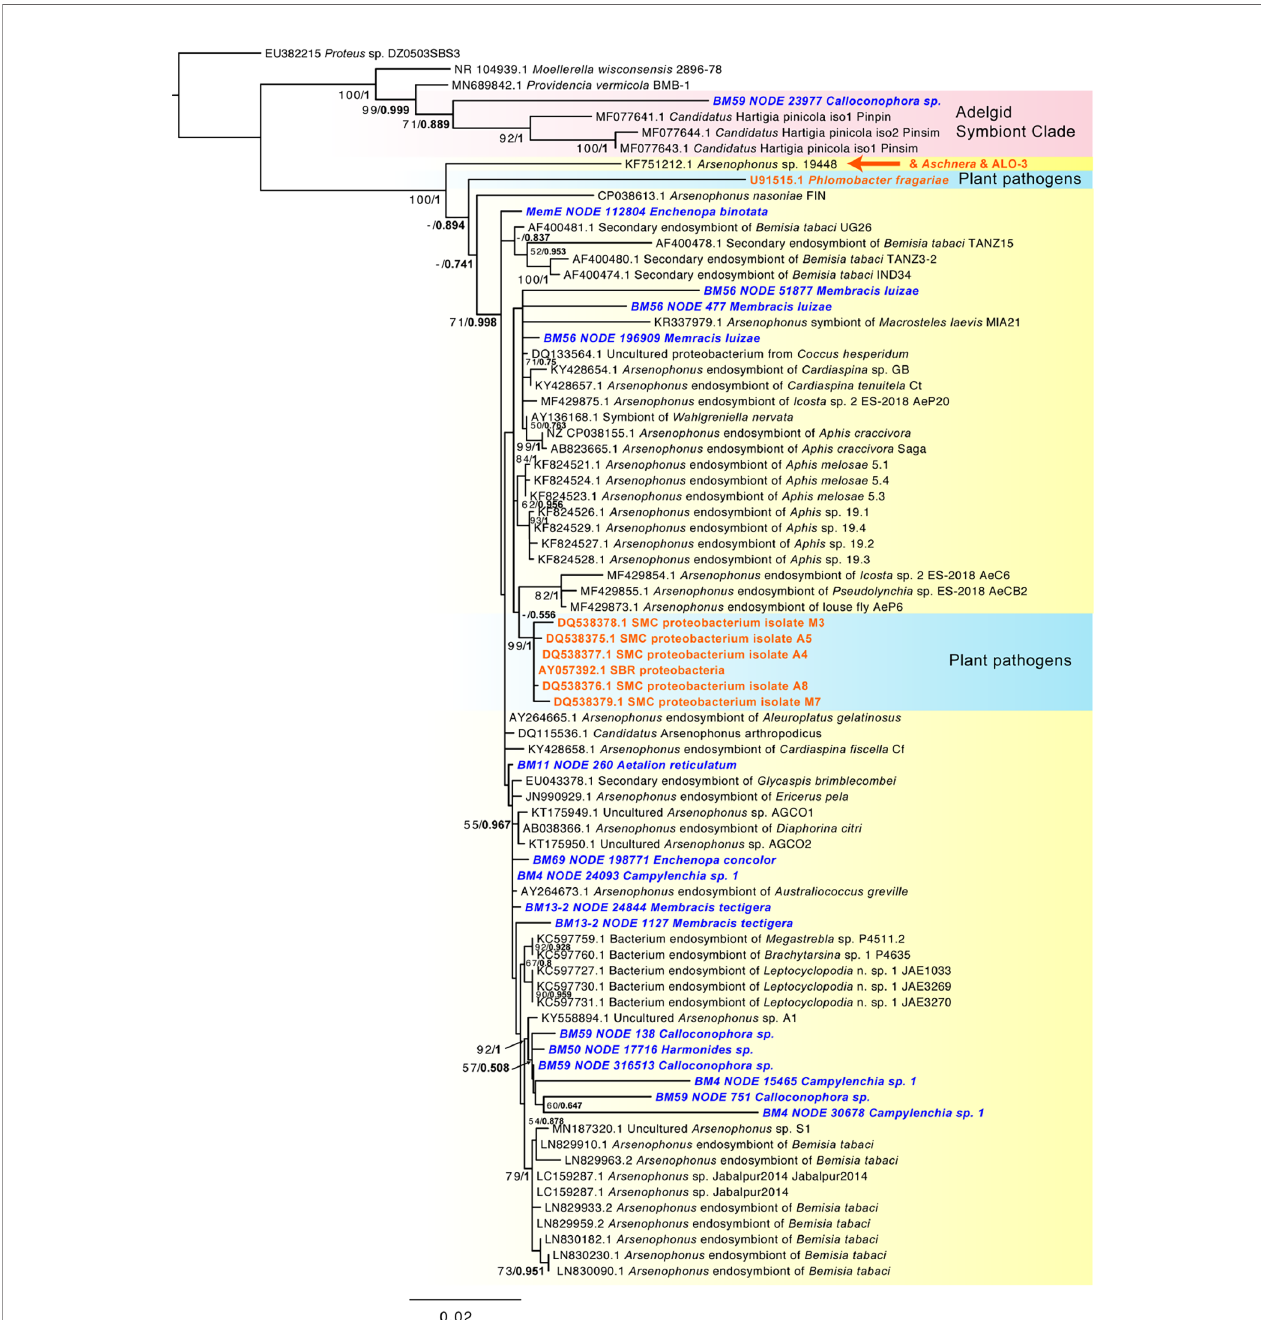
FIGURE 3 | Phylogeny of Arsenophonus -like sequence based on 1,562 aligned positions of the 16S rRNA gene for sequences from GenBank and membracid samples in this study (bold blue font). Maximum likelihood phylogeny reconstruction was performed in RAxML GTR+Gamma with 100 bootstrap replicates. Supported nodes that were obtained from Bayesian 50% majority rule analysis in MrBayes with GTR+G with 4 rate categories are shown as values on branches as ML bootstrap/Bayesian posterior, with the latter values in bold font. Various Arsenophonus -like groups organisms are highlighted with color shading (yellow – most secondary symbiont Arsenophonus , red – clade with adelgid symbionts, blue – plant pathogenic organisms). The position of the obligate symbiont Aschnera and ALO-3 clade is indicated in orange font. A phylogeny including additional shorter scaffolds is shown in Supplementary Figure S3